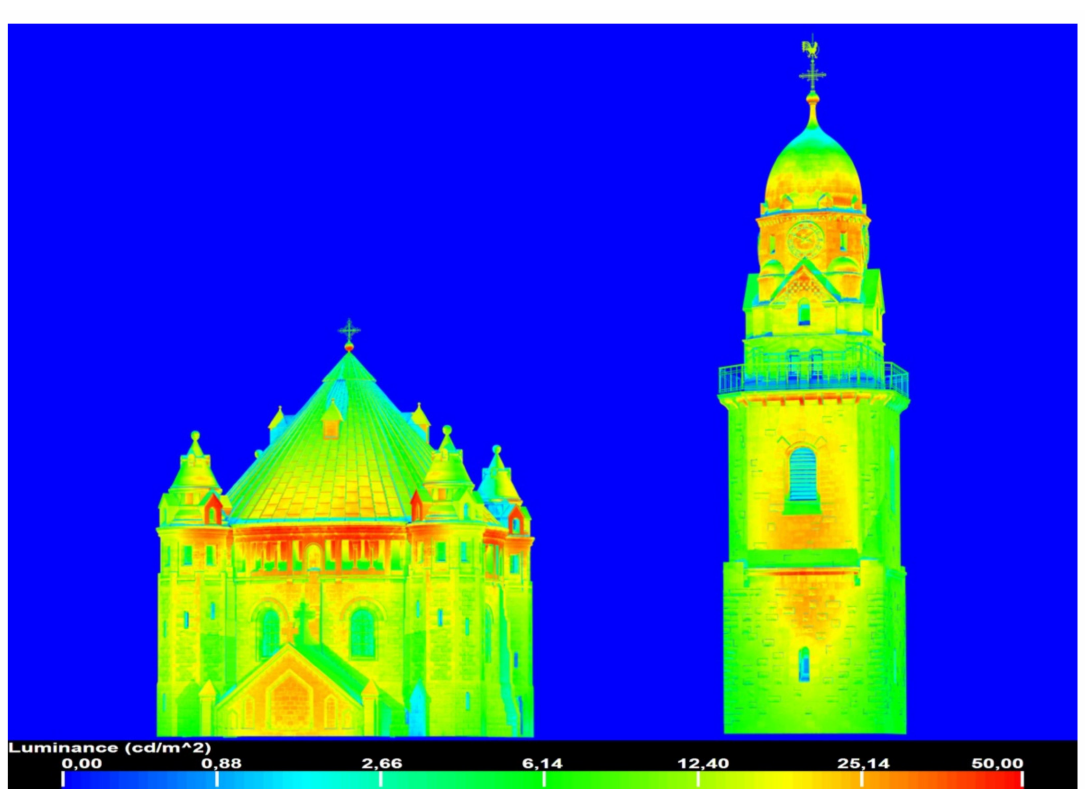
Figure 17. False colour luminance distribution for K2 observation direction.